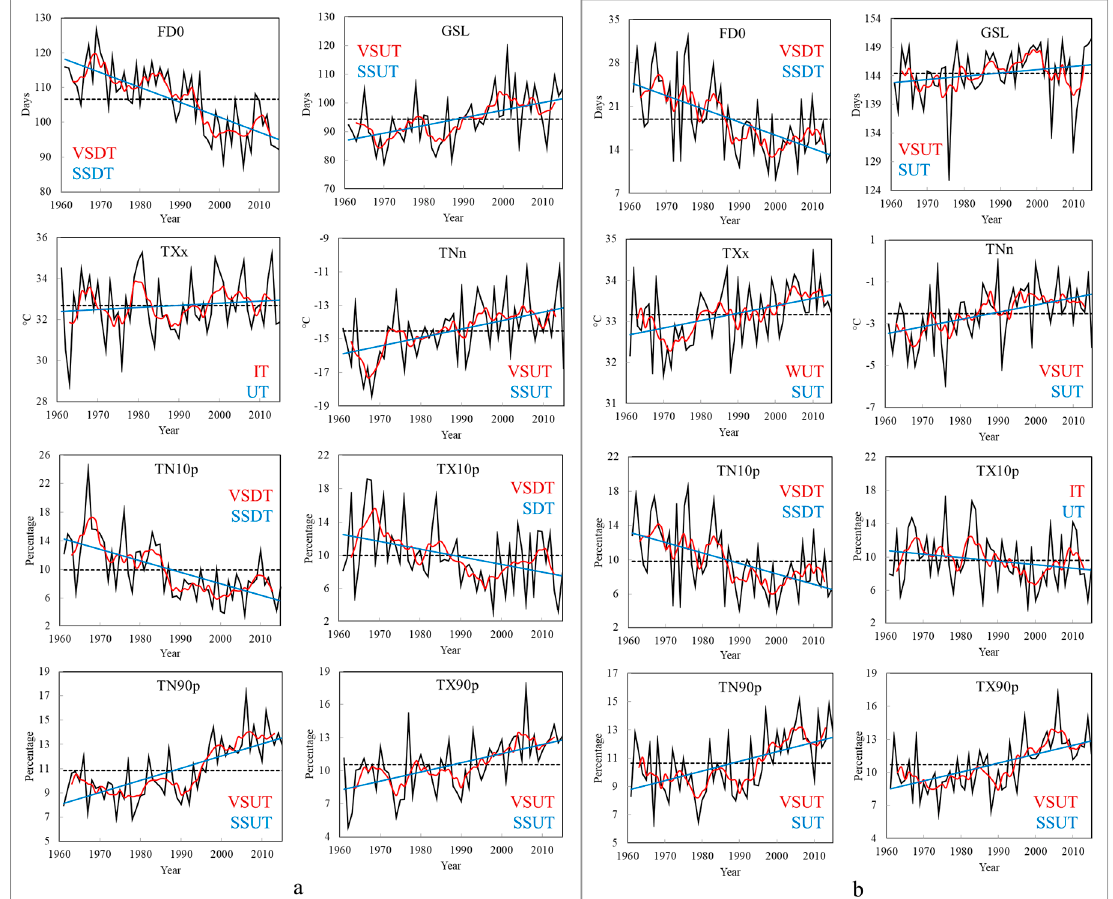
Figure 13. Annual variations of the spatially averaged extreme temperature indices and the trend strengths and trend stability test results during the growth period of October 1961 to May 2016. The black curves show the arithmetic average values of the total meteorological stations. The red curves give the five-year moving average. The black horizontal dotted lines represent the average level, and the blue lines show the trends. The northern China winter wheat region is denoted by ‘ a ’. The southern China winter wheat region is denoted by ‘ b ’. The trend strength is expressed in red letters. The stability of the trend is expressed in blue letters. VSDT represents very strong downward trends. VSUT represents very strong upward trends. WUT represents weak upward trends. IT represents insignificant trends. SSDT represents strongly stable downward trends. SSUT represents strongly stable upward trends. UT represents unstable trends. SDT represents stable downward trends. SUT represents stable upward trends.